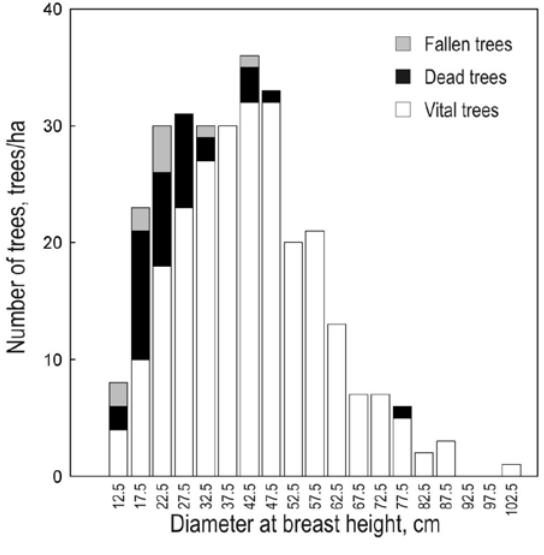
Number of dead and fallen trees in the total tree number between the two measurements